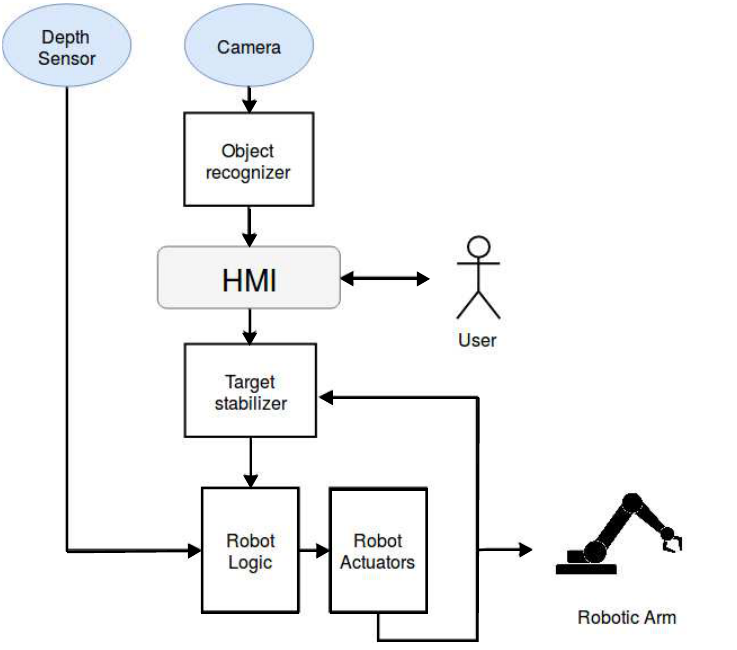
Figure 1. The Conceptual architecture. HMI, Human–Machine